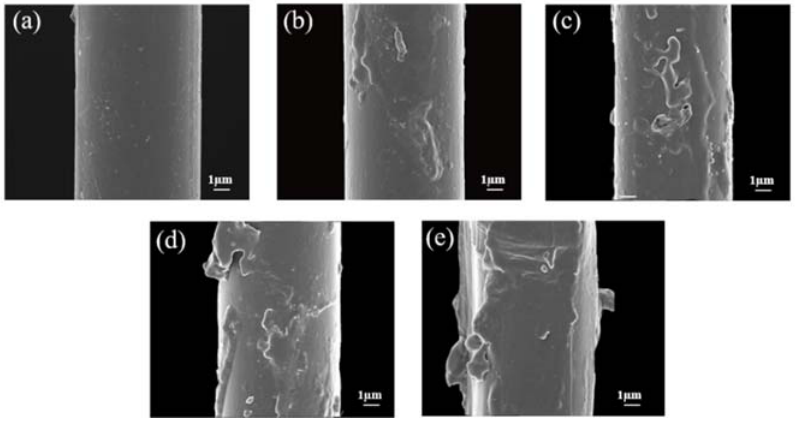
Figure 7. Macroscopic picture of Kevlar fibers before ( a ), and after ozone exposure for 100 h ( b ), 300 h ( c ), 500 h ( d ), 1000 h ( e